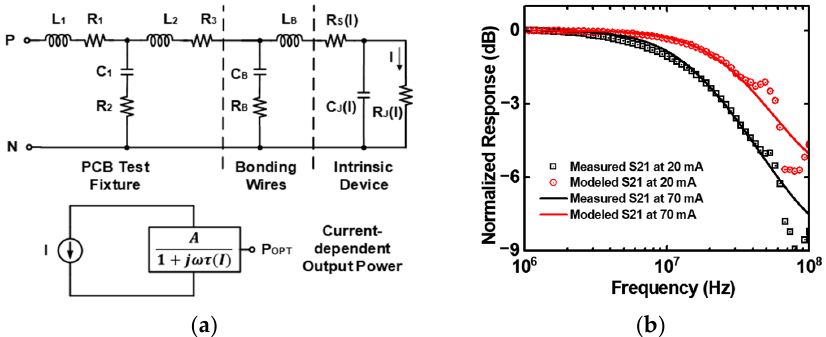
Figure 2. ( a ) Compact equivalent circuit model of µ-LED; ( b ) simulated and measured bandwidth curves of µ-LED.